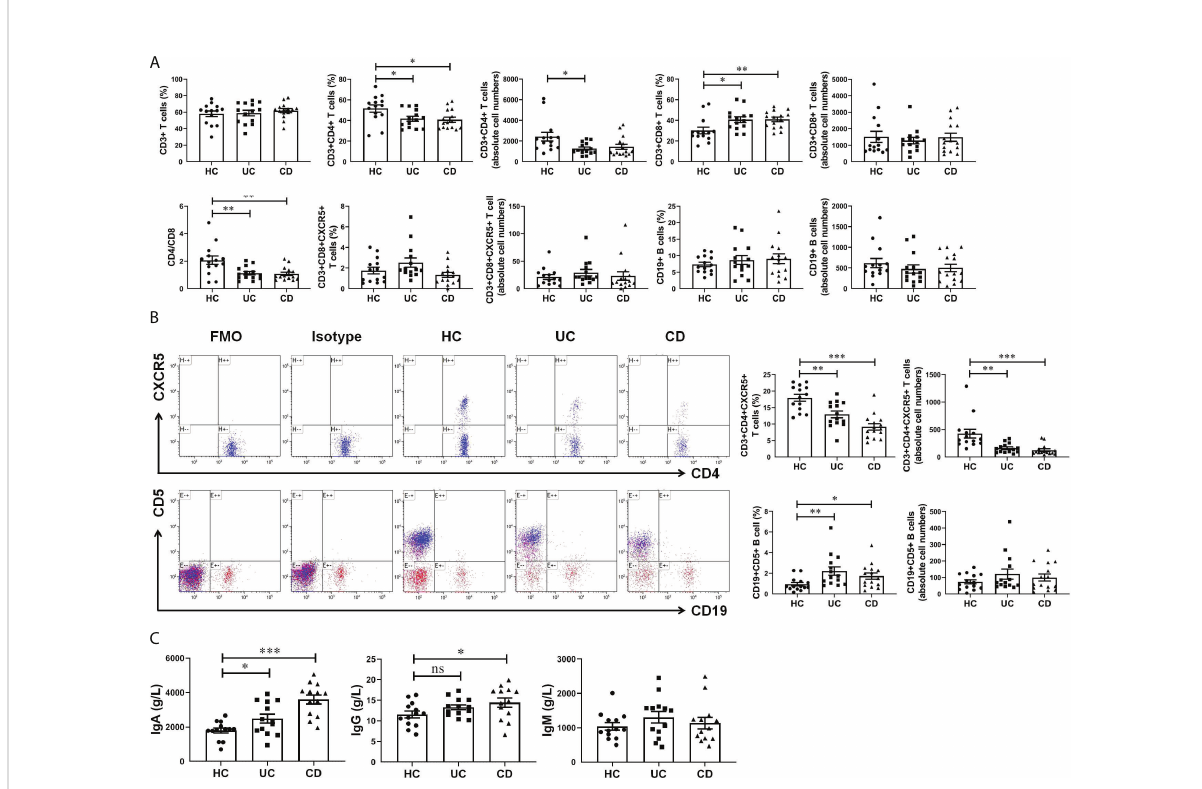
FIGURE 2 CXCL13regulated CD4+CXCR5+ T cells andCD19+CD5+ B cells in IBD patients, andtherefore enhanced antibody secretion. (A, B) Flow cytometry analysis of T cells and B cells subsets inperipheral bloodof IBD patients and healthy controls. (C) Electrochemiluminescenceanalysis of IgA, IgG and IgM in serum of IBD patientsand healthy controls. The results re fl ected the cellular and humoral immunity ofIBD patients. These results indicate that duringthe course ofIBD patients, CD4+CXCR5+ T cells decreased, CD19+CD5+ B cells increased, andIgA antibody secretionincreased. This phenomenon may be resulted fromthe elevationof CXCL13in IBD patients. Summarydata arepresented as mean ± SEM (n=13-15/group),with P valuesdetermined by two-tailed Student ’ s t test. * P < 0.05; ** P < 0.01; *** P < 0.001.ns, not statistically signi fi